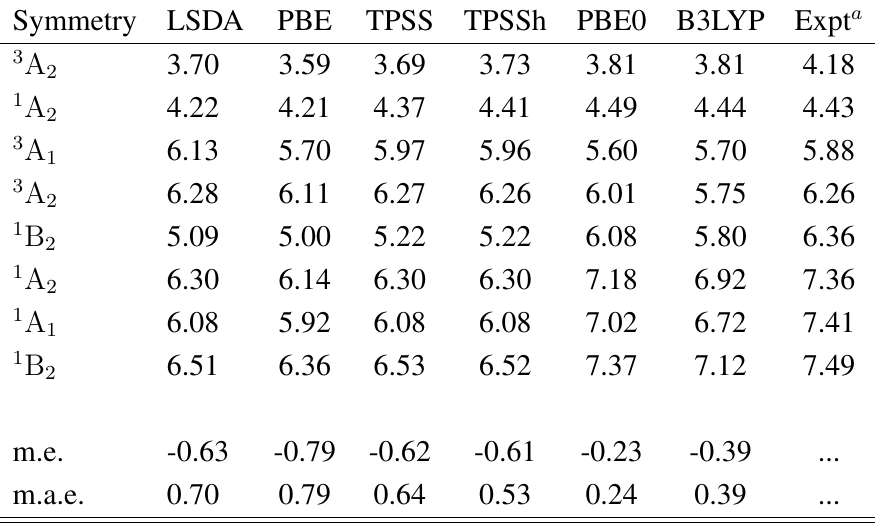
Table 6. The same as Table 2, but for acetone ((CH 6.17